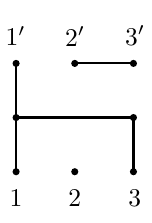
Figure 1: This graph corresponds to the connectivity state described by a partition P = {{ 2 } , { 1,1 (cid:48) ,3 } , { 2 (cid:48) ,3 (cid:48) }}